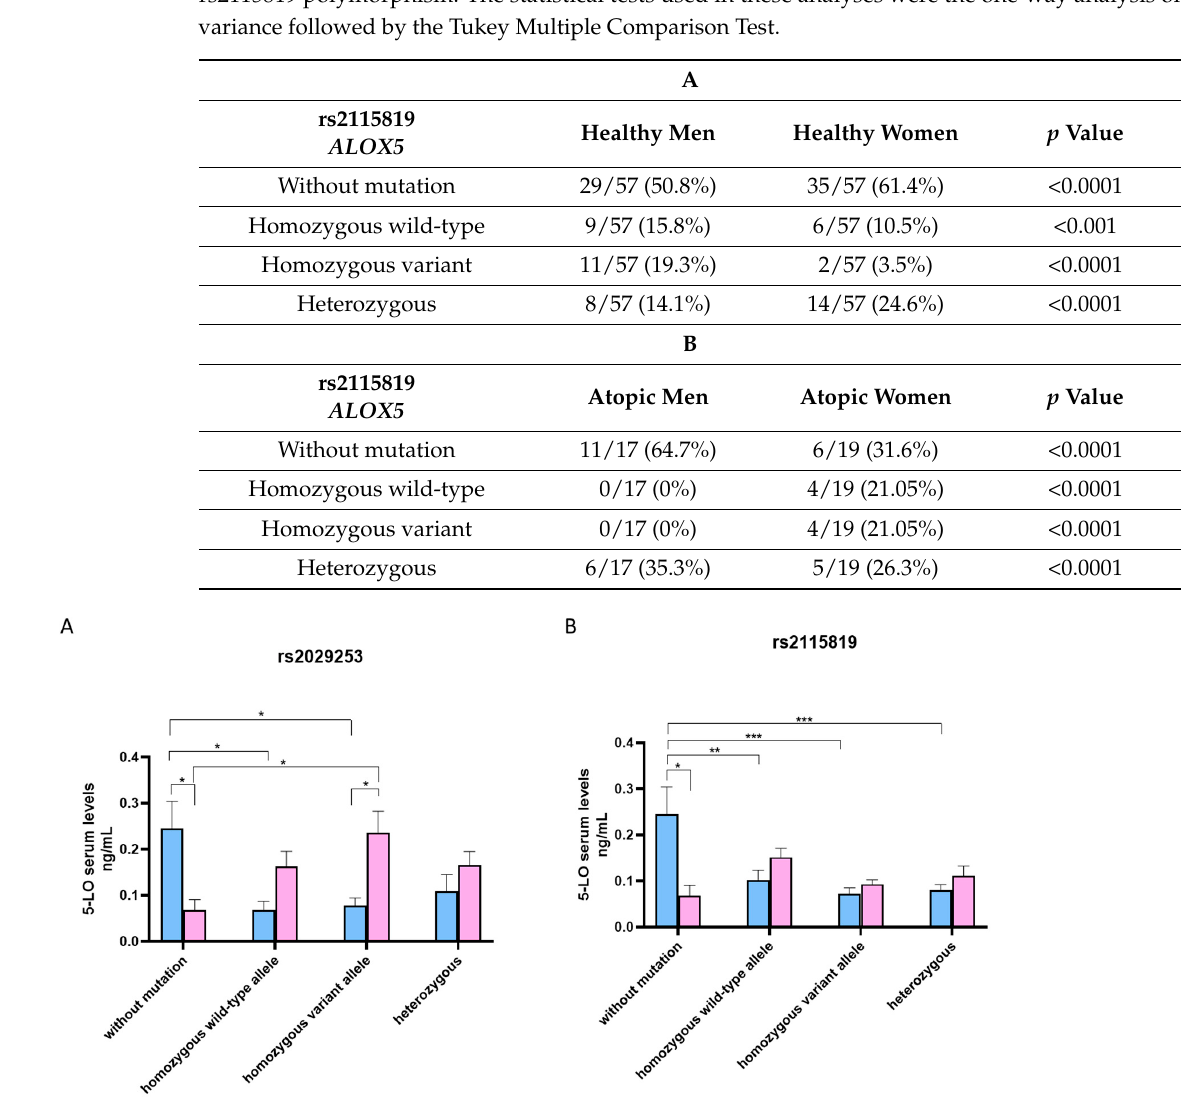
Figure 1. ( A ) Median 5-LO serum levels in M (blue) and W (pink) according to genotype ALOX5 rs2029253 polymorphism. Biological replicate: 4 M (2 healthy and 2 atopic) and 4 W (2 healthy and 2 atopic) without mutation; 4 M (all healthy) and 6 W (3 healthy and 3 atopic) carrying homozygous wild-type allele; 3 M (all healthy) and 4 W (3 healthy and 1 atopic) carrying homozygous variant allele; 6 M (3 healthy and 3 atopic) and 4 W (2 healthy and 2 atopic) carrying heterozygous alleles. ( B ) Median 5-LO serum levels in M (blue) and W (pink) according to genotype ALOX5 rs2115819 polymorphism. Biological replicate: 4 M (2 healthy and 2 atopic) and 4 W (2 healthy and 2 atopic) without mutation; 6 M (all healthy) and 8 W (4 healthy and 4 atopic) carrying homozygous wild-type allele; 6 M (all healthy) and 6 W (2 healthy and 4 atopic) carrying homozygous variant allele; 7 M (4 healthy and 3 atopic) 6 W (3 healthy and 3 atopic) carrying heterozygous alleles. All samples were run in duplicate and results were shown as means ± SEM. The statistical tests used in these analyses were the one-way analysis of variance followed by the Tukey Multiple Comparison Test. * p < 0.05, ** p < 0.01, *** p < 0.001. The serum LTB4 levels showed a trend similar to the 5-LO serum levels. Indeed, M without mutations showed higher levels of serum LTB4 compared to subjects presenting the rs2029253 polymorphism, except for the heterozygous (Figure 2A). Conversely, W with the ALOX5 rs2029253 polymorphism showed significantly higher levels of LTB4 , spe- cifically, those carrying the homozygous wild-type allele ( p < 0.01) (Figure 2A). M without mutations showed higher levels of serum LTB4 compared to subjects pre- senting the rs2115819 polymorphism, except for the heterozygous (Figure 2B). In contrast, W with the ALOX5 rs2115819 polymorphism showed higher levels of LTB4 , although it only reached statistical significance in subjects carrying the homozygous wild-type allele ( p < 0.01) (Figure 2B).